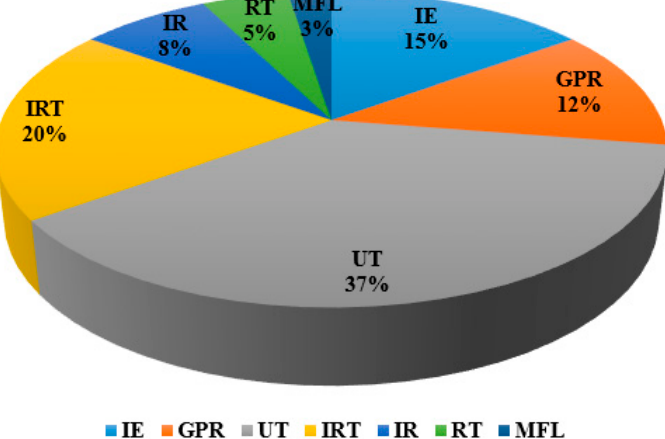
Figure 7. Statistical representation of NDT methods most applicable to detect corrosion.